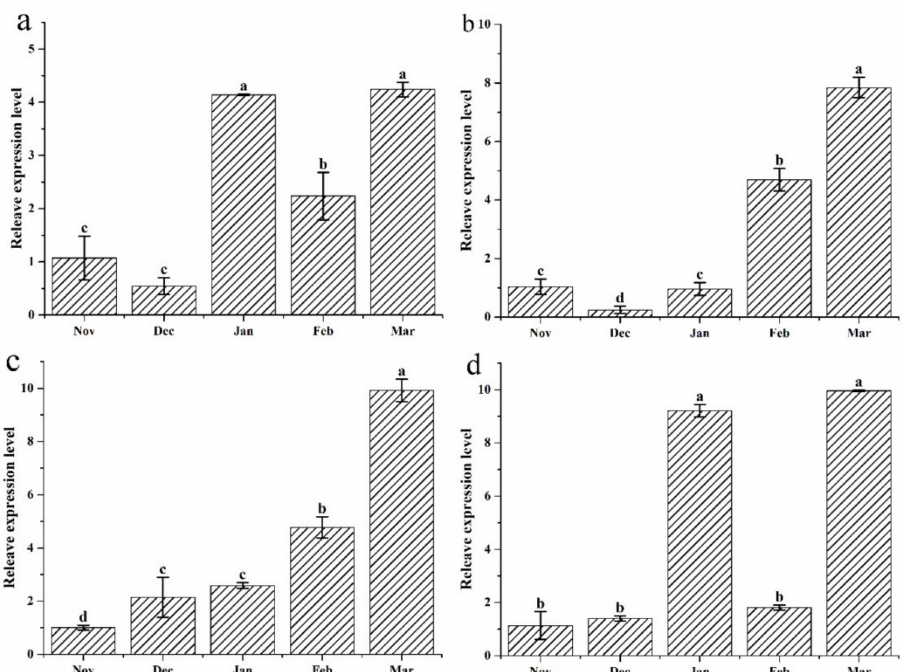
Figure 6. Expression of antioxidant enzyme genes in N. yezoensis collected from different cultivation periods. ( a ) NADH oxidase (NOX) , ( b ) Superoxide dismutase (SOD), ( c ) Catalase (CAT), ( d ) Ascorbate peroxidase (APX). Data were Mean ± SD ( n = 3). Different letters indicated significant differences ( p < 0.05).